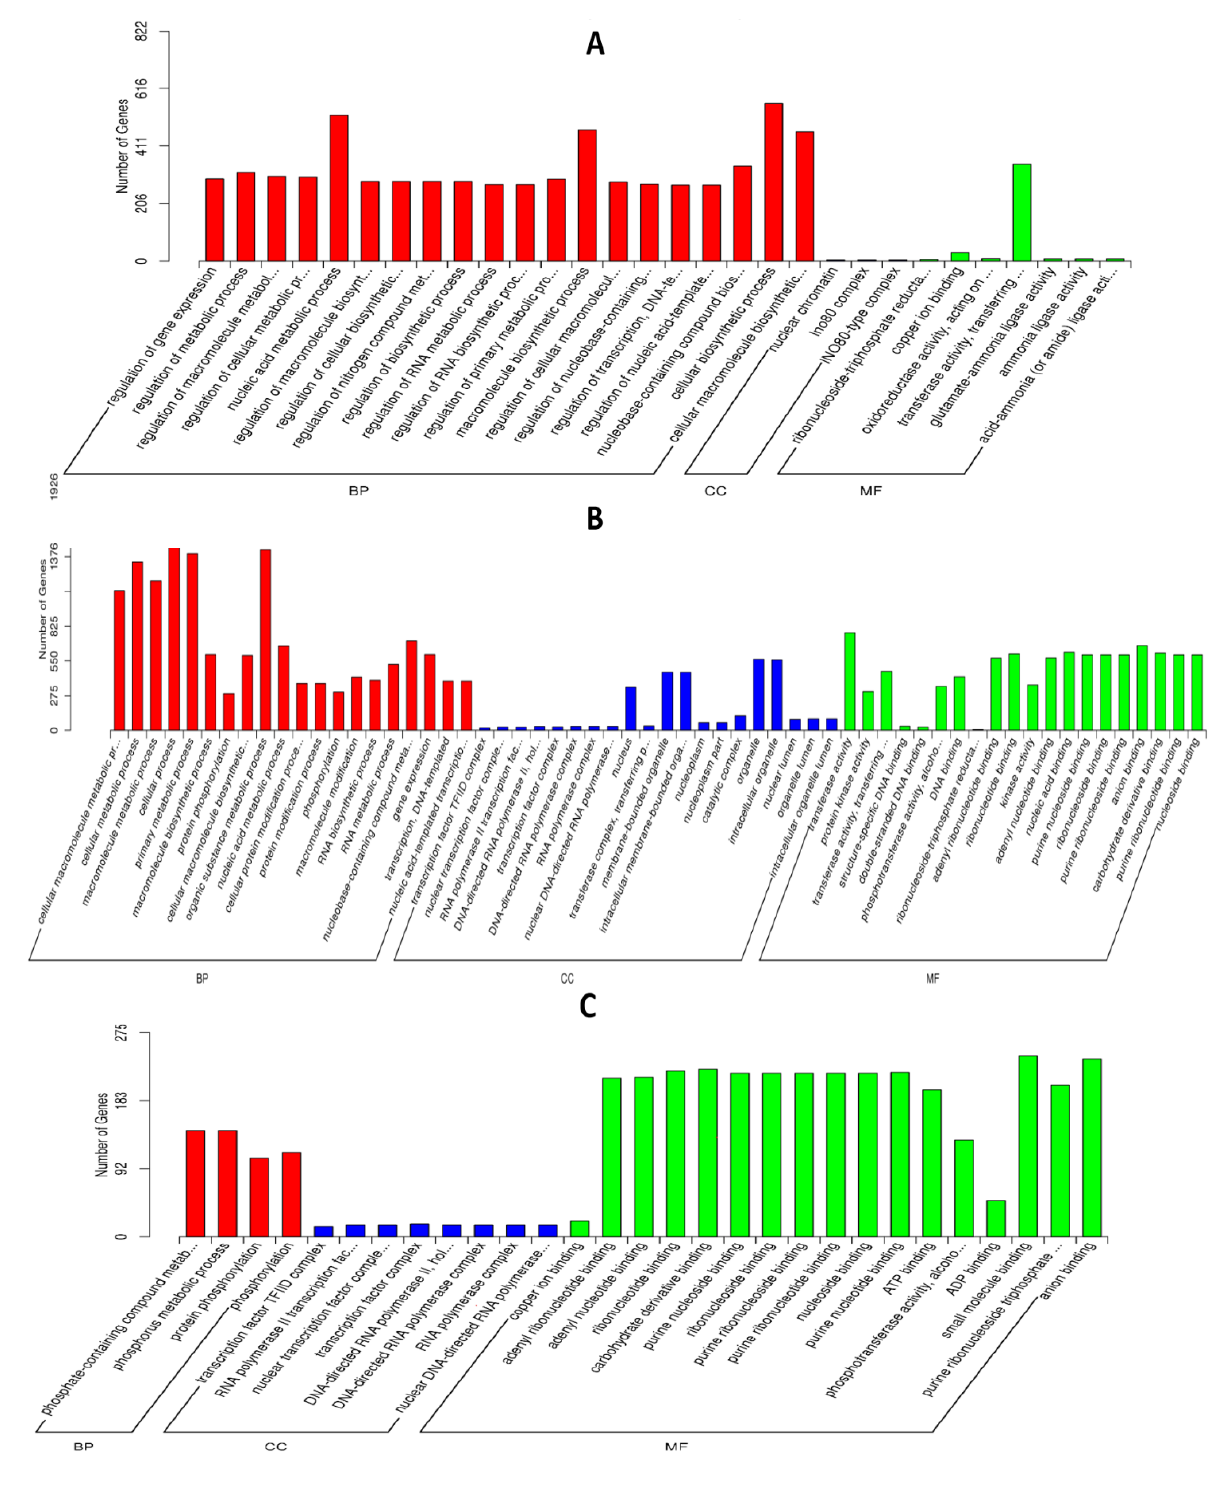
Figure 7. The relative expression of miRNAs and their target genes involved in the growth-regulating factor, promoter-binding-like protein, and transcription factor. ( A ) The chart shows that miRNA_novel 1 was downregulated and its target genes HORVU7Hr1G012380 and HORVU5Hr1G055920 were down-regulated. ( B ) The chart shows that miRNA_444b was downregulated and its target genes HORVU3Hr1G076030 was upregulated but HORVU5Hr1G006020.8 were down-regulated. ( C ) The chart shows that miRNA_novel 22 was upregulated and its target genes HORVU4Hr1G082910 was upregulated, too. The other target gene HORVU2Hr1G085210 was